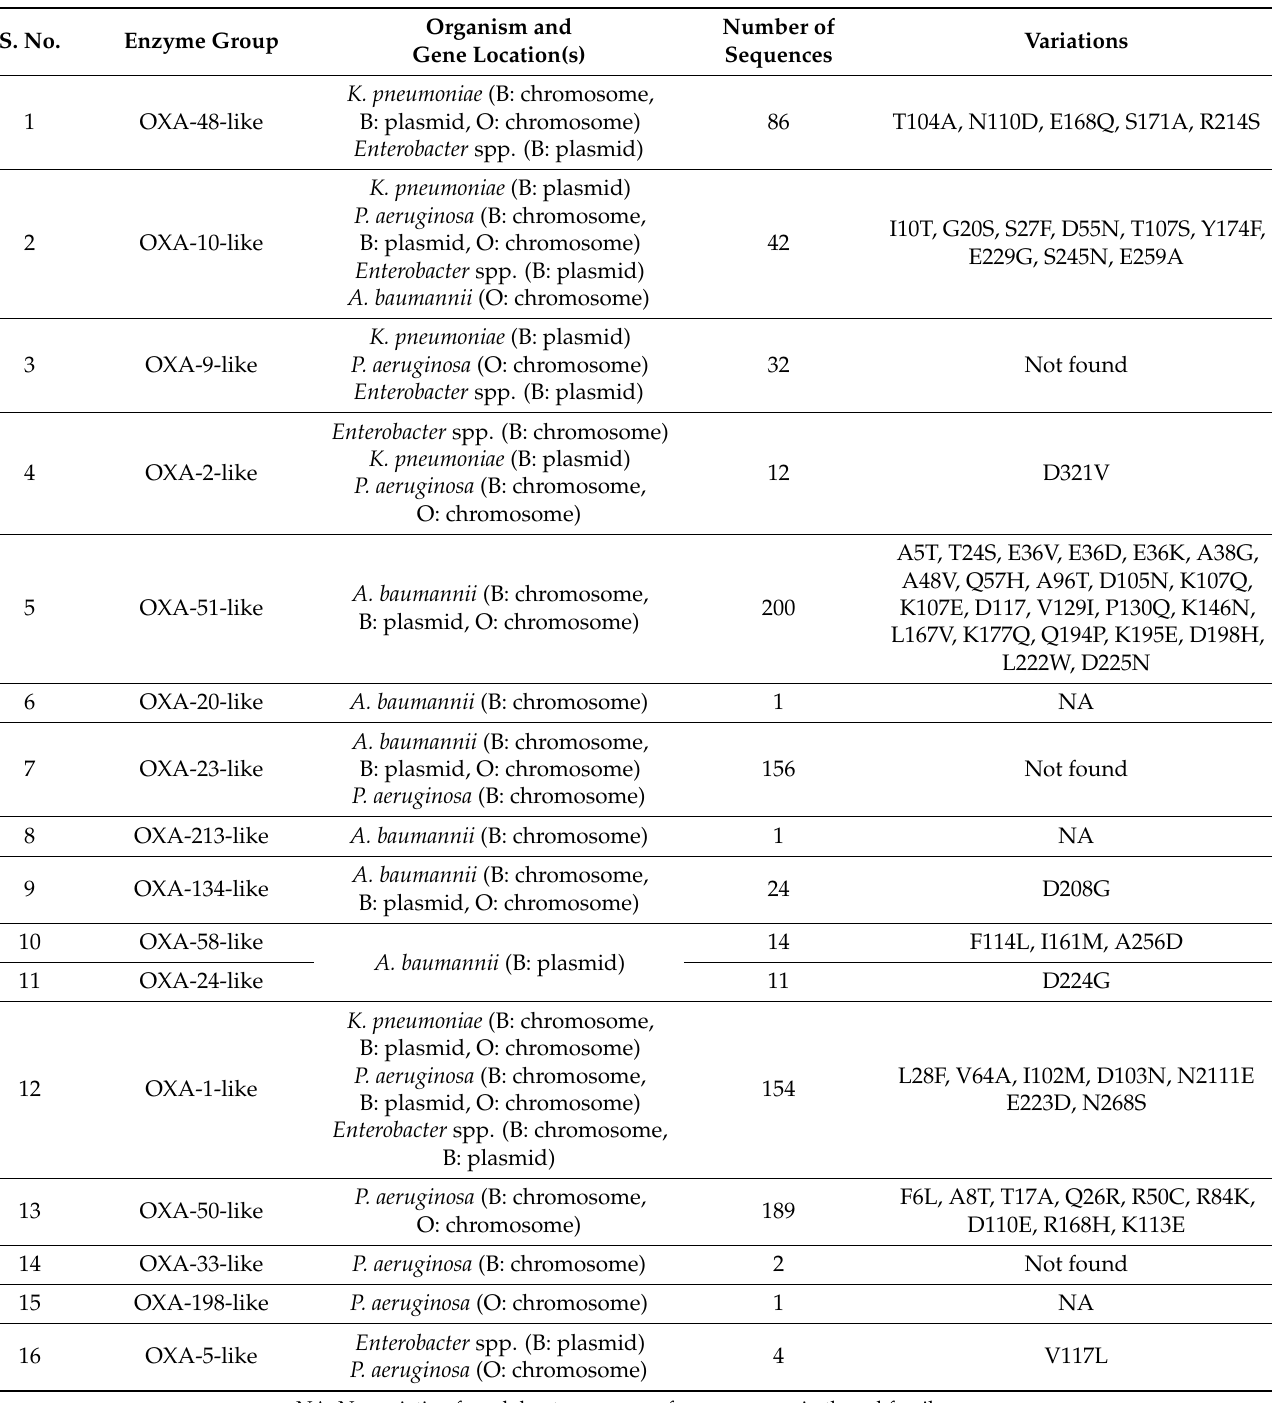
Table 2. List of variations identified each of 16 OXA